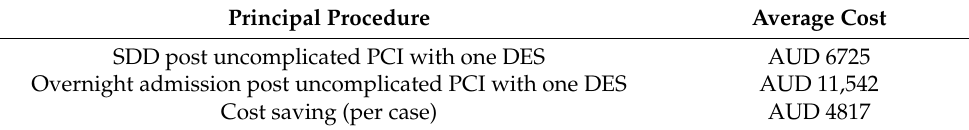
Table 7. Cost difference between SDD and overnight admission following PCI at St George